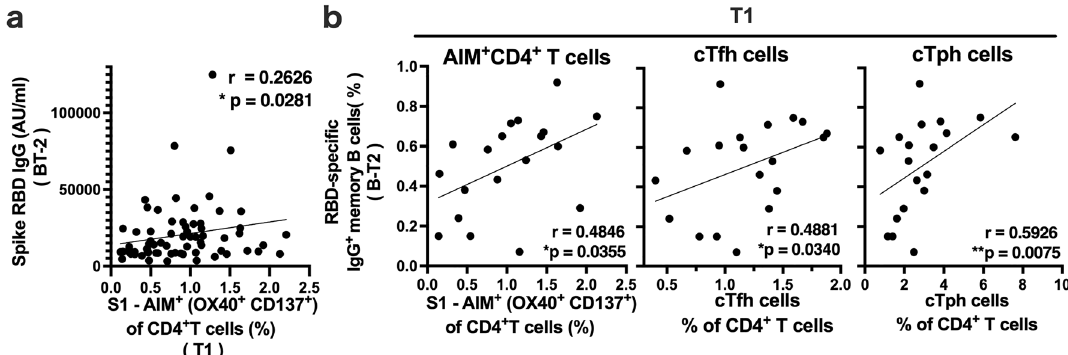
Figure 4. Association of SARS-CoV-2 mRNA vaccine-induced early CD4 + T cell responses and B cell memory. ( a ) The correlation between the frequencies of S1-reactive AIM + CD4 + T cells at 1 week after the 2nd dose of the BNT162b2 mRNA vaccine (T1) and serum SARS-CoV-2 IgG levels at 2 months after the 3rd vaccine dose (B-T2) is shown. ( b ) Correlations of the frequency of SARS-CoV-2 spike RBD-specific IgG + memory B cells at B-T2 with the frequencies of S1-reactive AIM + CD4 + T cells, cTfh cells and cTph cells at T1 are shown. Each dot indicates the value for one individual. Correlations were analyzed using Spearman’s correlation analysis. * P < 0.05, ** P <